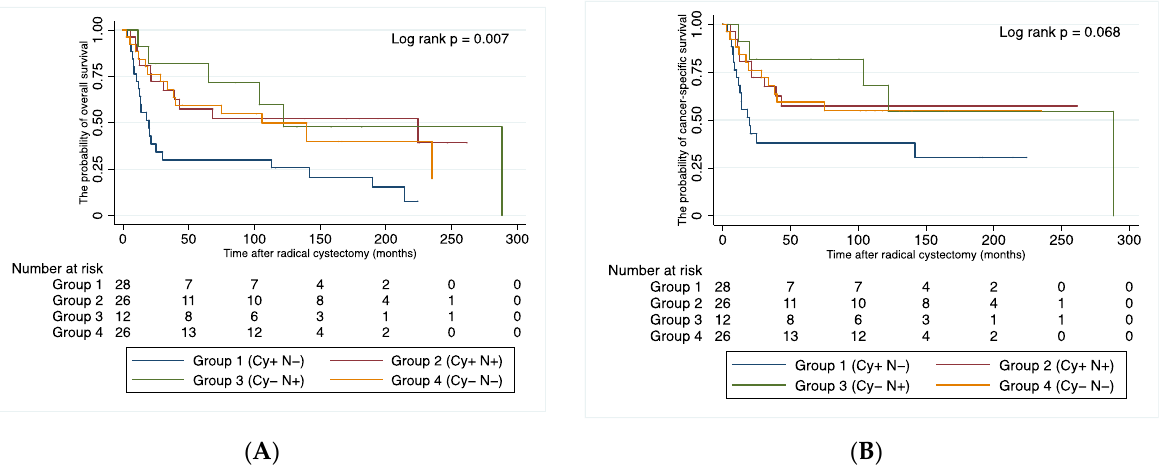
Figure 4. Probability of ( A ) overall survival and ( B ) cancer-specific survival after radical cystectomy by DJ-1 expression group. Group 1 — cytoplasm-positive, nucleus-negative; Group 2 — cytoplasm- by DJ-1 expression group. Group 1—cytoplasm-positive, nucleus-negative; Group 2—cytoplasm- positive, nucleus-positive; Group 3 — cytoplasm-negative, nucleus-positive; Group 4 — cytoplasm- positive, nucleus-positive; Group 3—cytoplasm-negative, nucleus-positive; Group 4—cytoplasm- negative, nucleus-negative. negative, nucleus-negative.